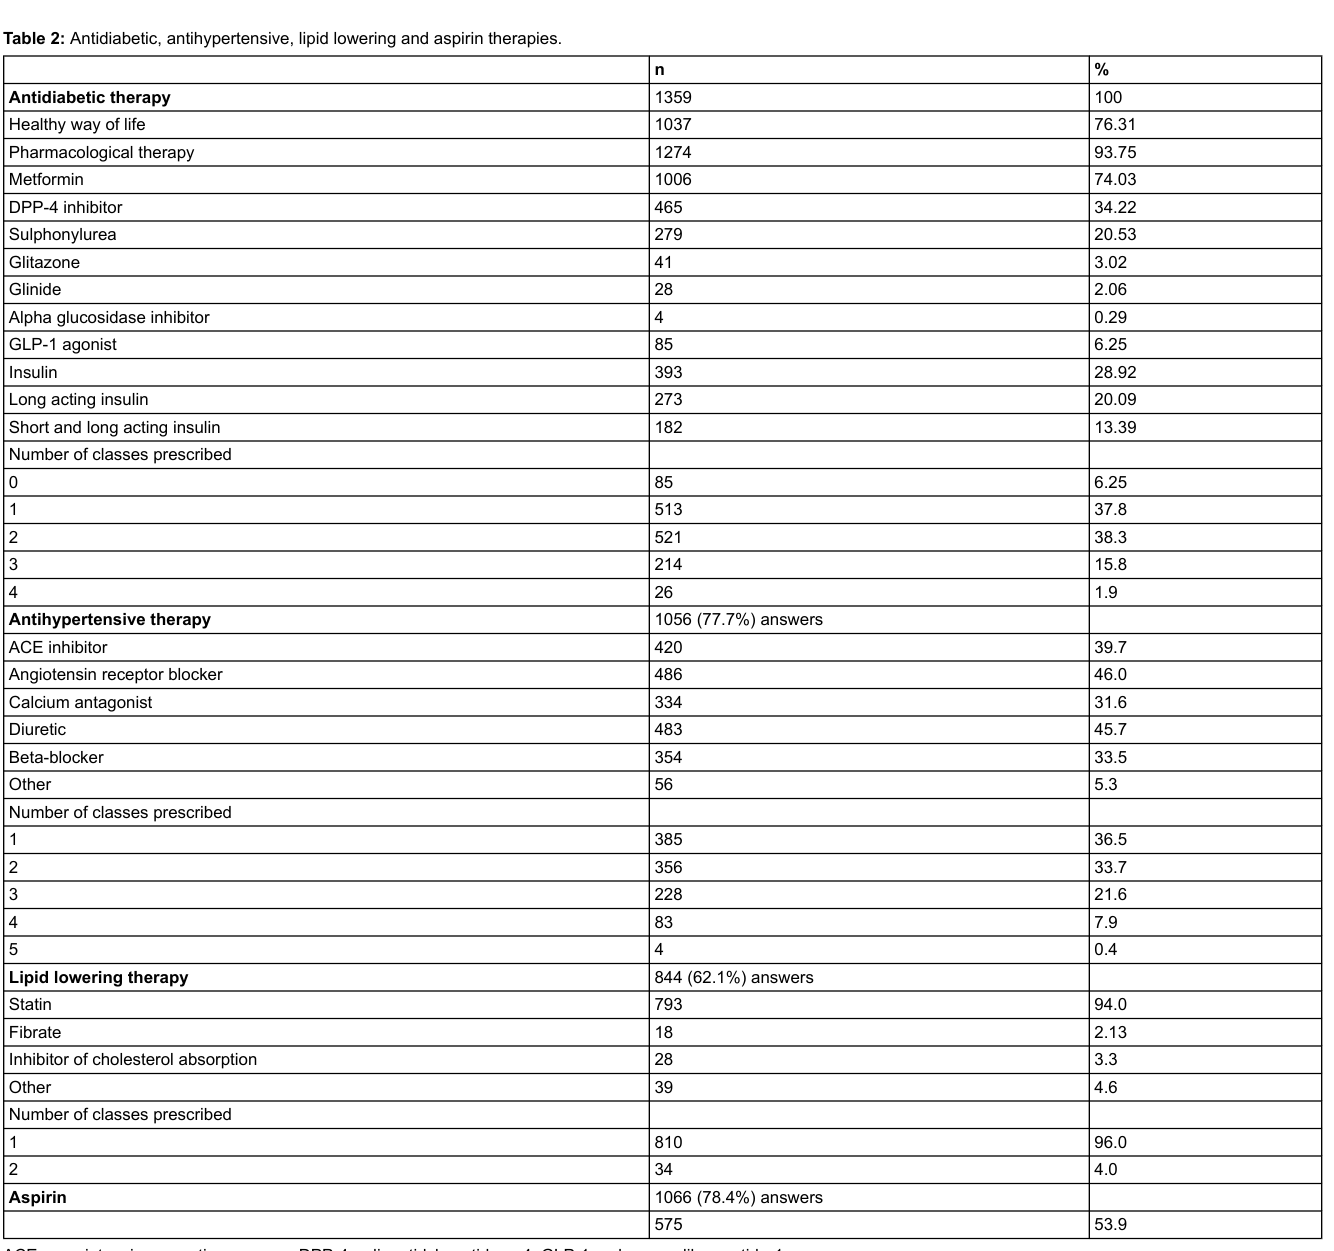
Table 2: Antidiabetic, antihypertensive, lipid lowering and aspirin therapies.